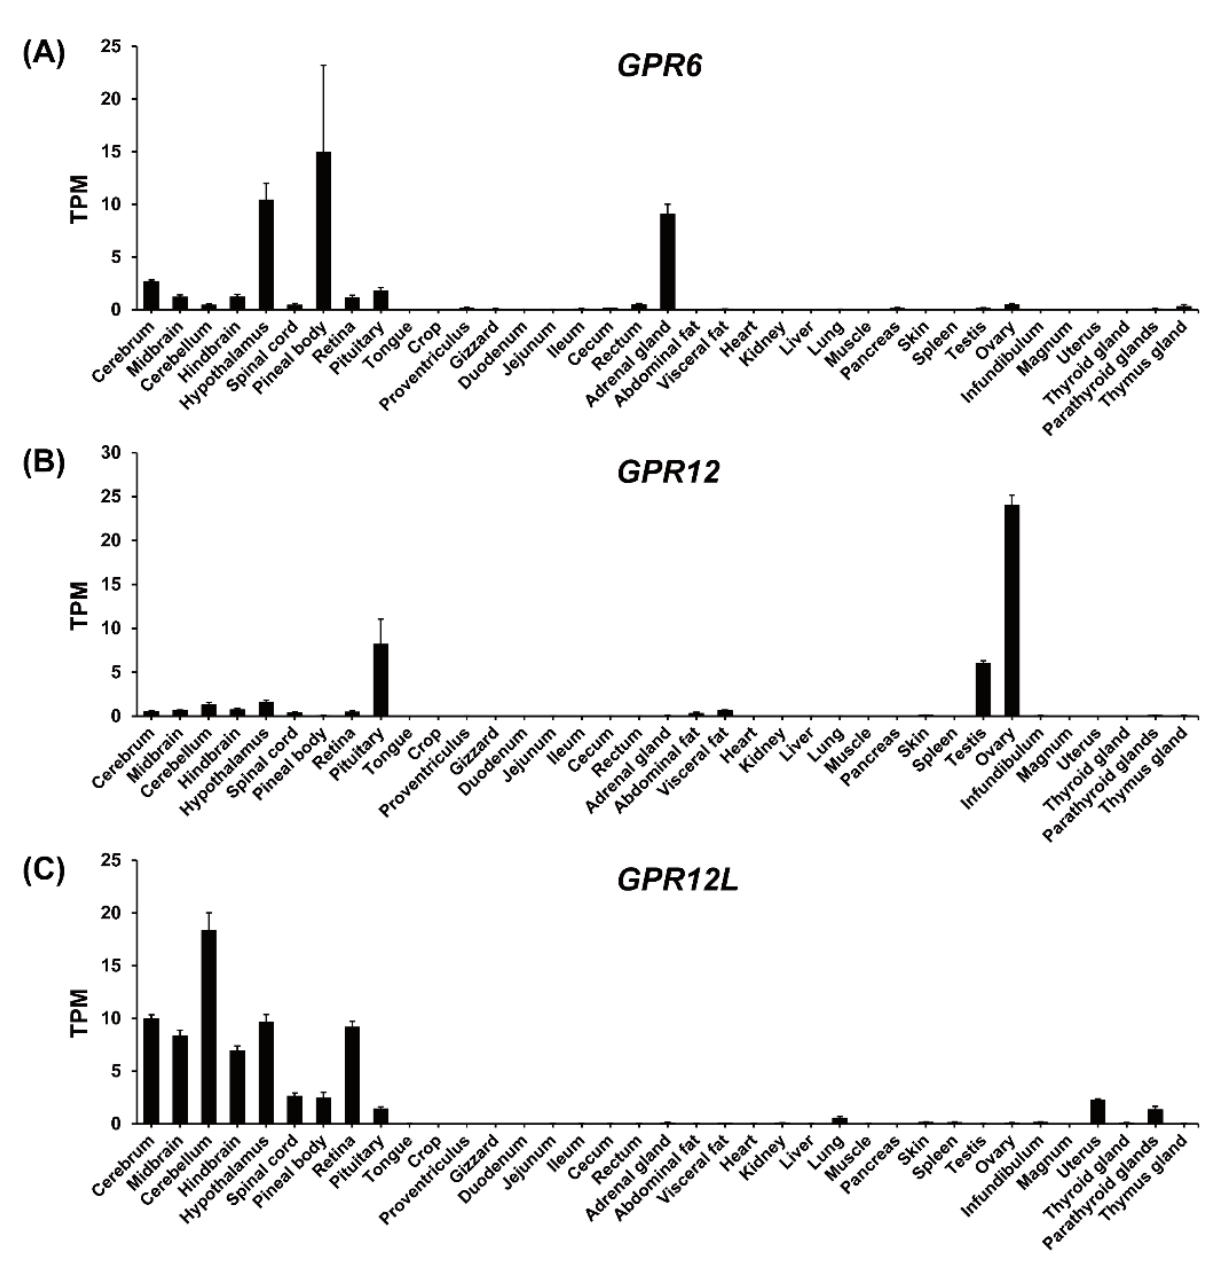
Figure 5. RNA-seq data analysis showing the expression of GPR6 ( A ), GPR12 ( B ), and GPR12L ( C ) in adult chicken tissues. Each data point represents the mean ± SEM of 6 individual adult chickens (3 males and 3 females) ( N = 6).